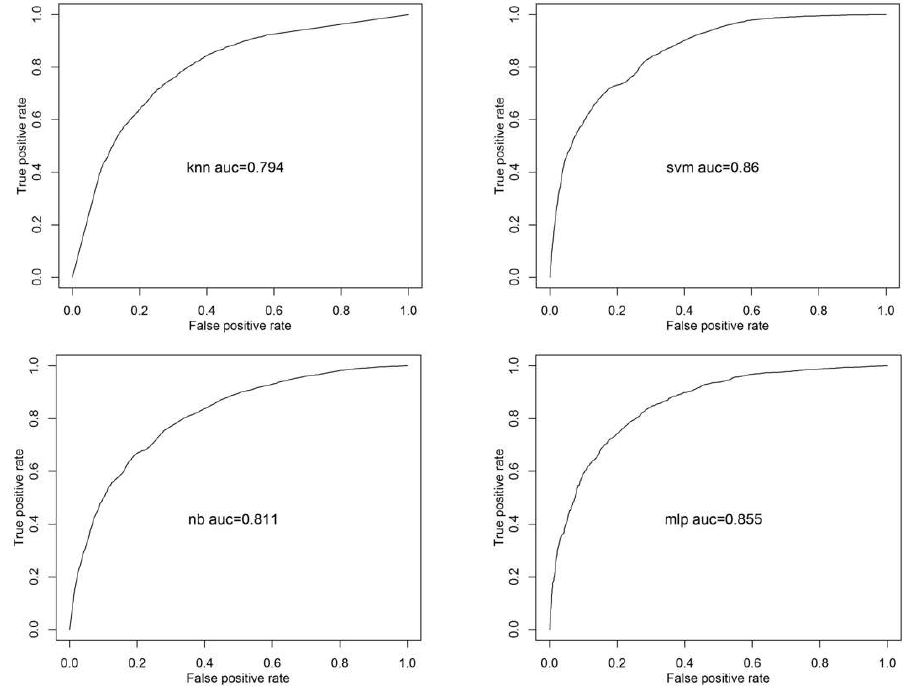
Figure 3. ROC curves for scenario-type detection based on using kNN, SVM, NB, and MLP classifiers with varSelRF algorithm. Table 5. Average classification accuracy for scenario-type detection.